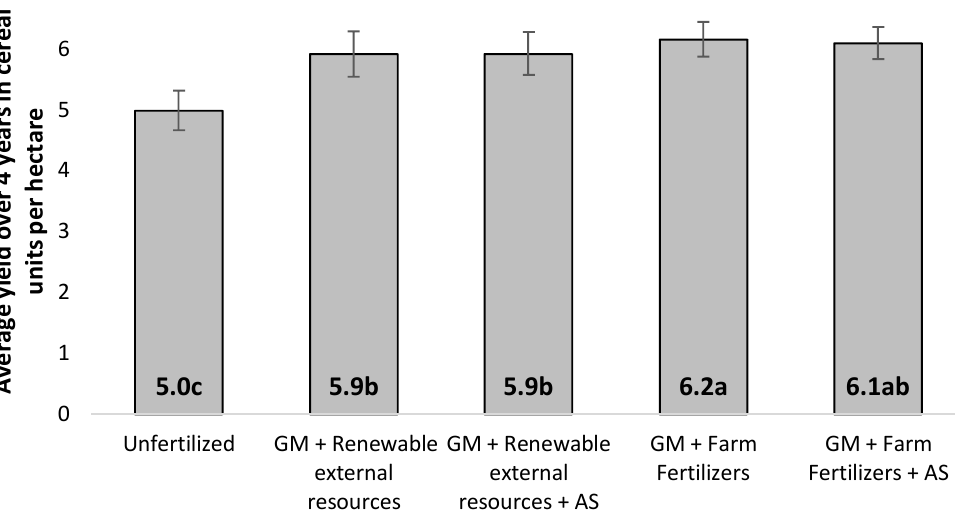
Figure 9. Average crop yield over four experimental years recalculated to the cereal units per hectare units (observed treatments). Error bars represent the standard error (SE). Different letters mean statistical difference. Cereal unit of winter wheat = 1 t/ha of winter wheat grain × 1; cereal unit of potatoes = 1 t/ha of potato tubers × 0.25; cereal unit of winter wheat spelt = 1 t/ha of spelt grain × 1; cereal unit of field pea = 1 t/h of field pea grain × 1.20; cereal unit of spring barley = 1 t/ha of barley grain × 1; cereal unit of silage corn = 1 t/ha of fresh silage × 0,15.